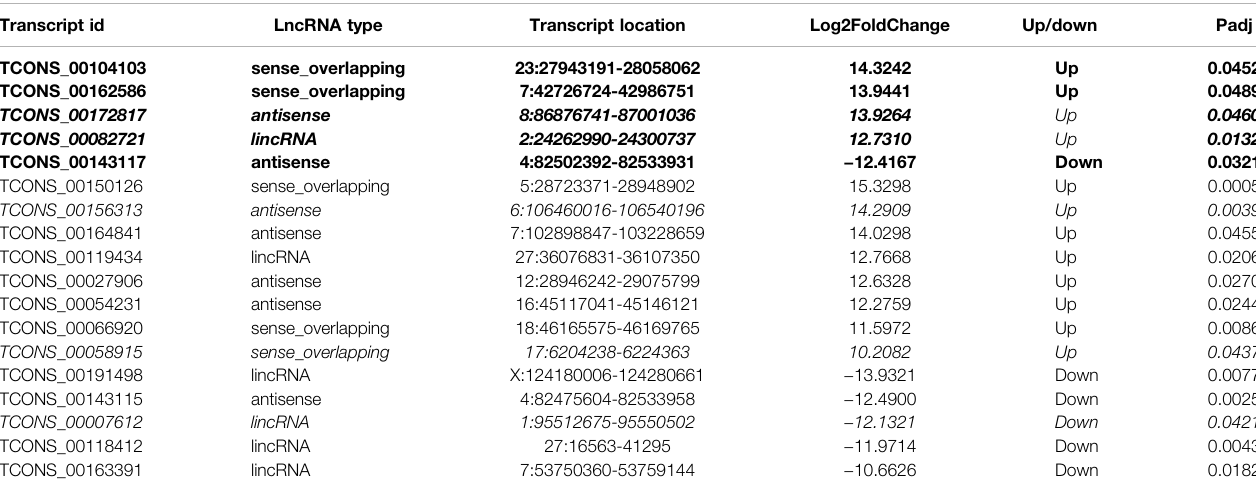
TABLE 4 | DELs related to lipid metabolism predicted by co-expression and